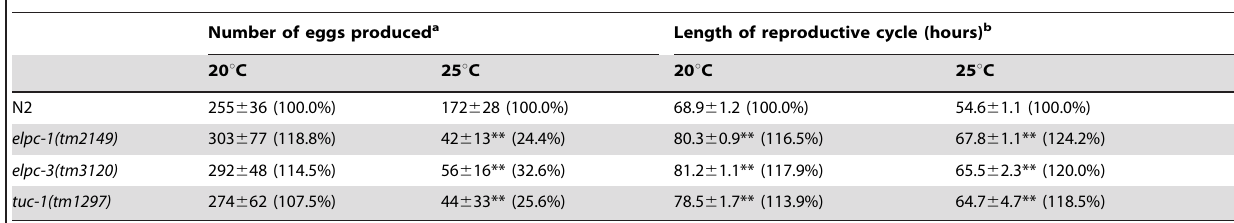
Table 2. elpc-1(tm2149) , elpc-3(tm3120) and tuc-1(tm1297) Worms Display Temperature Sensitive Fecundity and Life Cycle Defects.